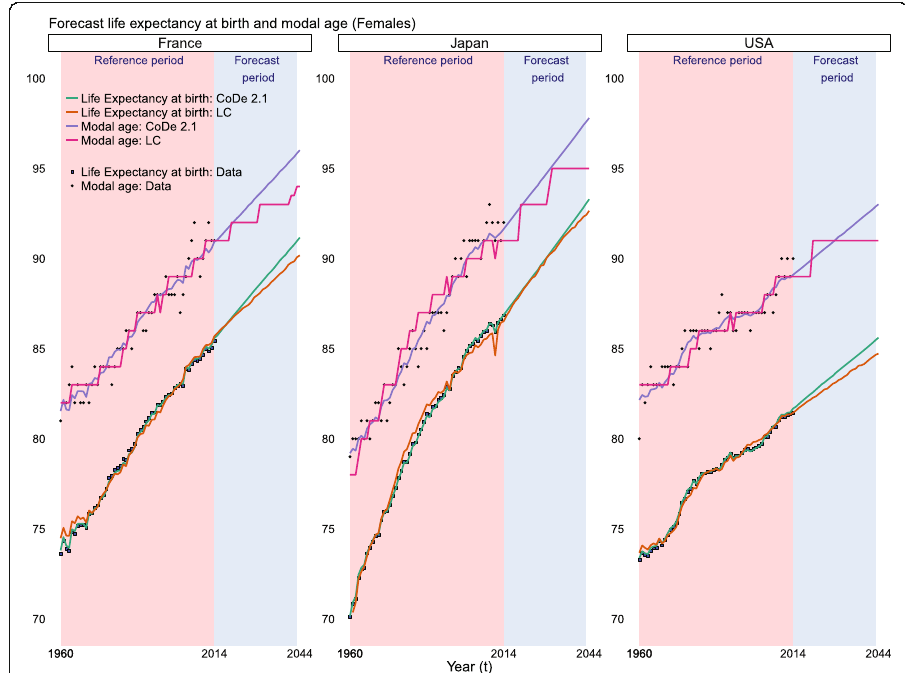
Fig. 3 Estimation and out-of-sample projections of life expectancy at birth and of the modal age of females using the CoDe 2.1 model and the LC model. The reference period is 1960 – 2014 (pink); the projection